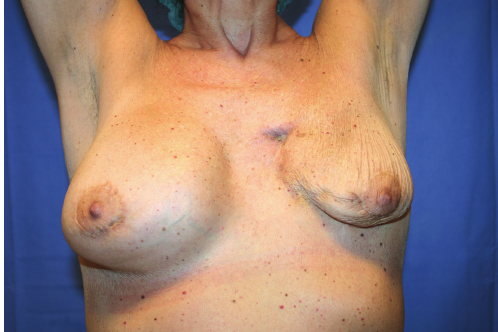
Figure 1: Breast fistula before fat graft.